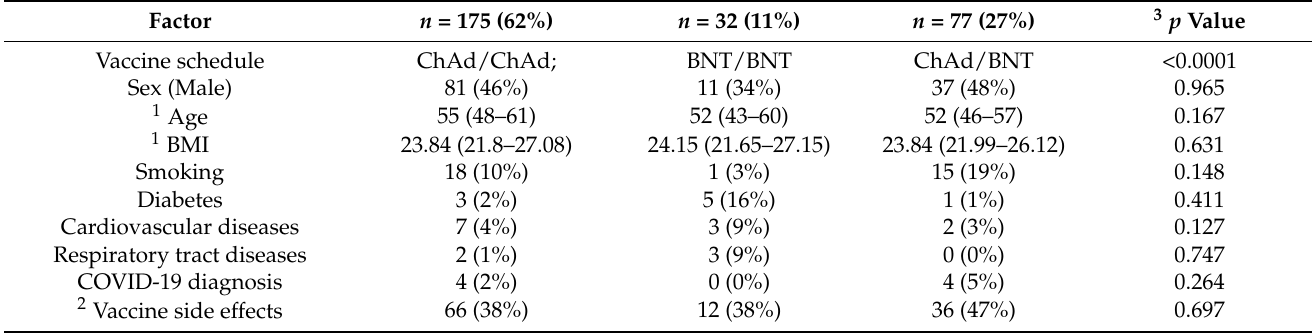
Table 2. Characteristics of a subgroup of 284 subjects included in the logistic regression